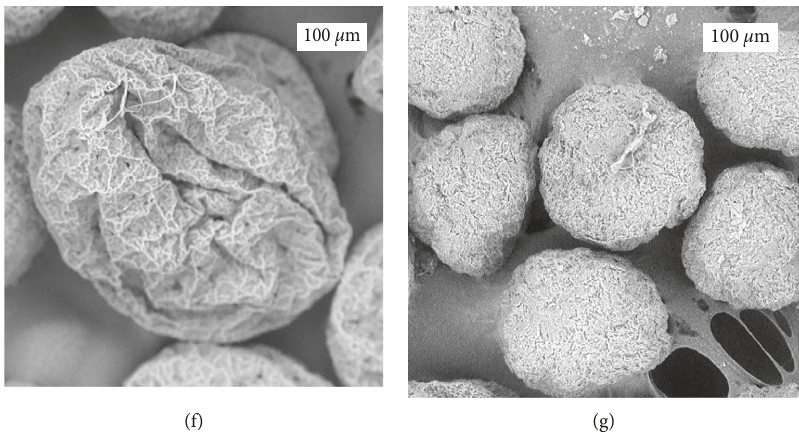
Figure 6: SEM images of the microparticles stabilized with PVA (a), ChN-K (b, d, f), and ChN-X (c, e, g) at concentrations of 0.1 (b, c), 0.5 (d, e), and 1 wt.% (f, g) in the aqueous